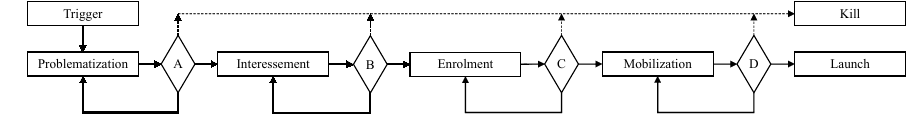
Fig. 1. The Stakeholder Onboarding